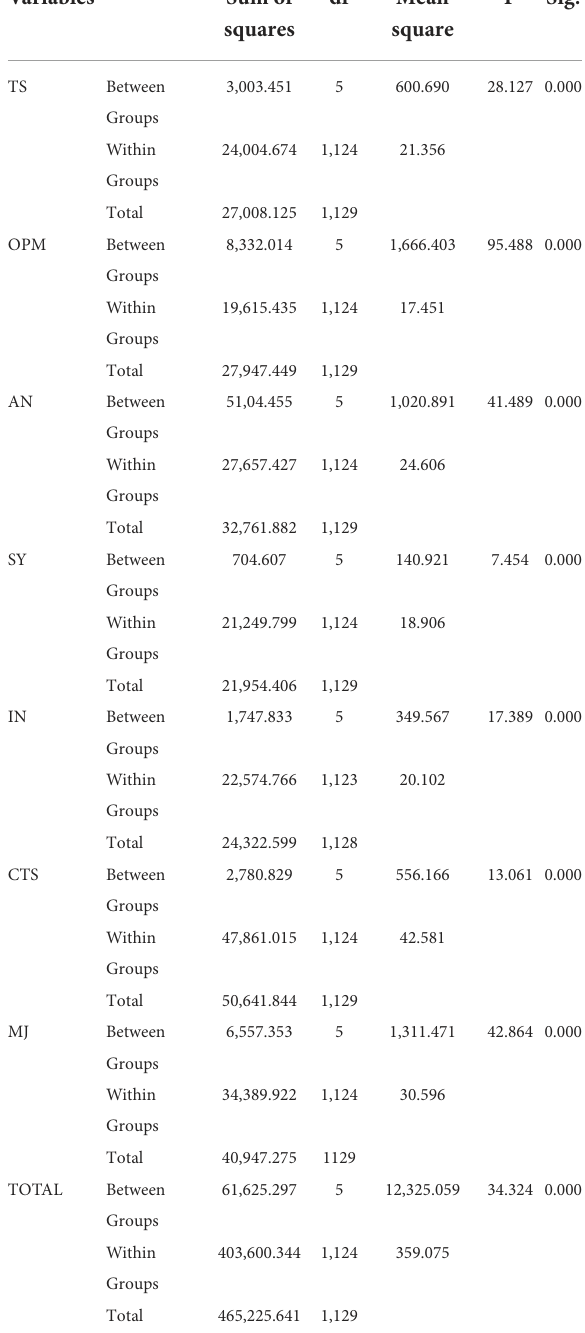
TABLE 7 Summary of results regarding ANOVA analysis of critical thinking disposition levels of participants in terms of their socio-economic